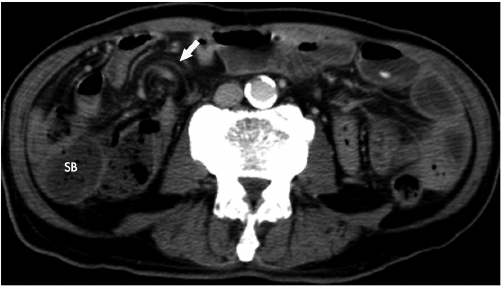
Figure 4. The ‘‘whirl’’ sign. Axial MDCT image shows the whirl appearance of twisted mesenteric vessels (arrow), supplying the obstructed small bowel (SB) lying laterally to the colon. pneumatosis intestinalis, (3) portal venous gas, and (4) bowel wall